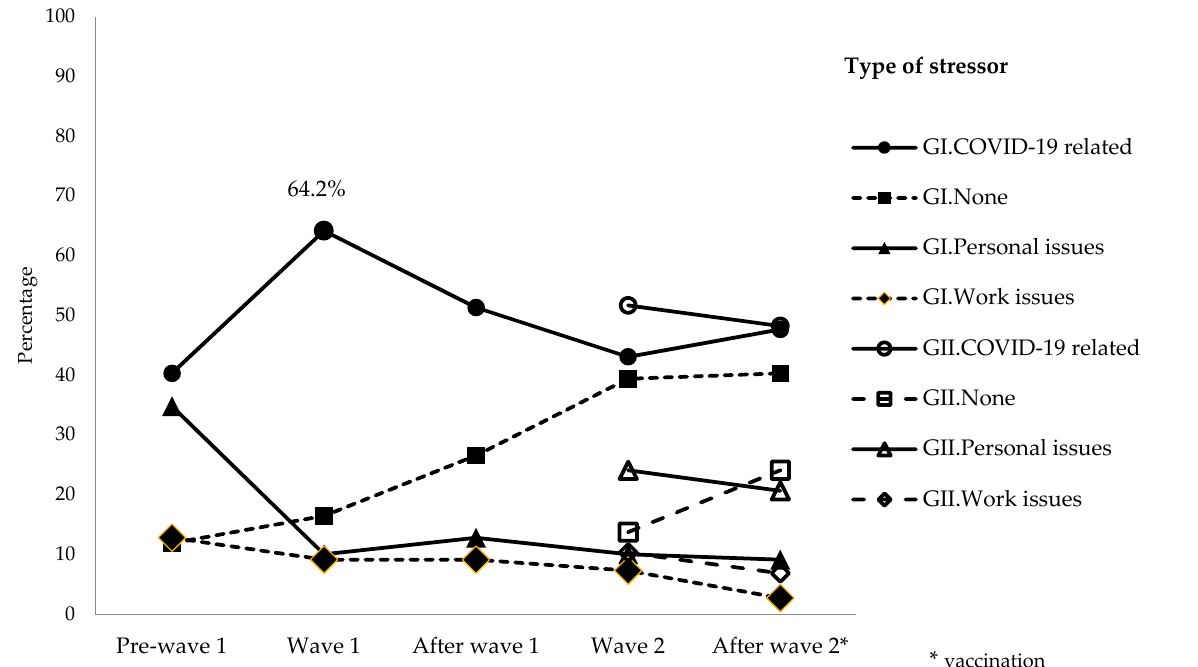
Figure 4. Frequency of reporting acute stress, according to the type of stressor, during the follow-up of participants included in the study, either at the first epidemic wave (GI) or the second epidemic wave (GII). The time of vaccination is highlighted with an asterisk.